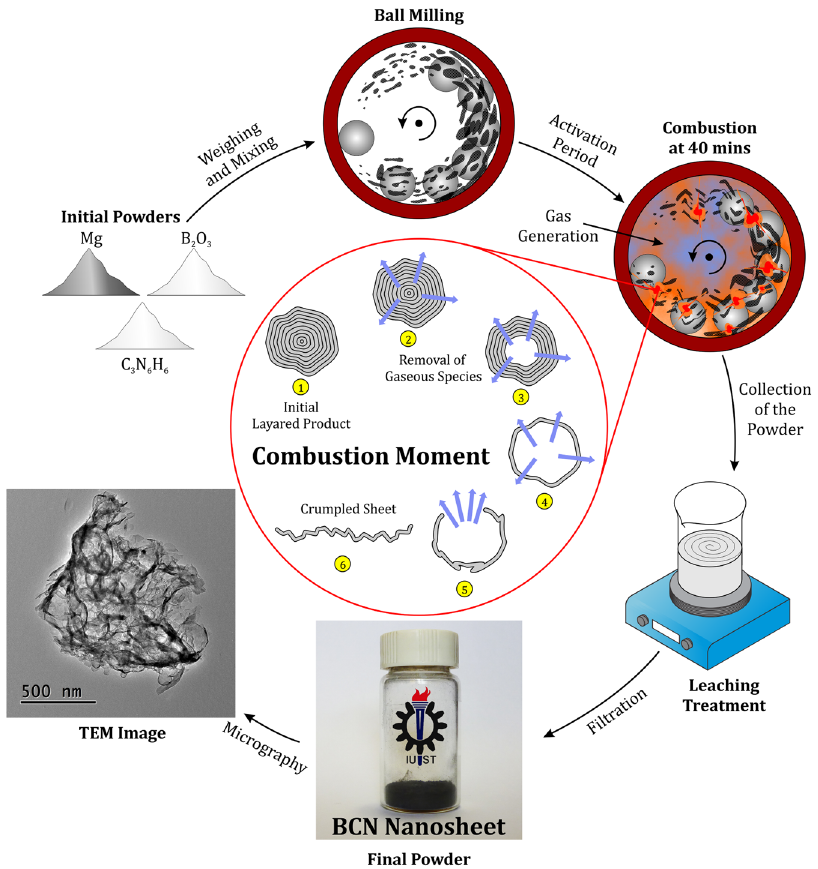
Figure 7. Schematic representation of the synthesis of BCN